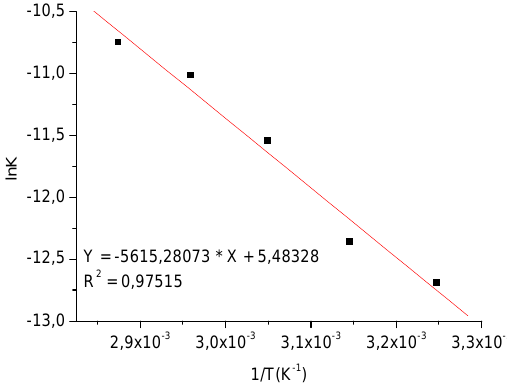
Figure 7. Linear plot of ln K versus 1/T resulting from esterification of oleic acid catalyzed by tin